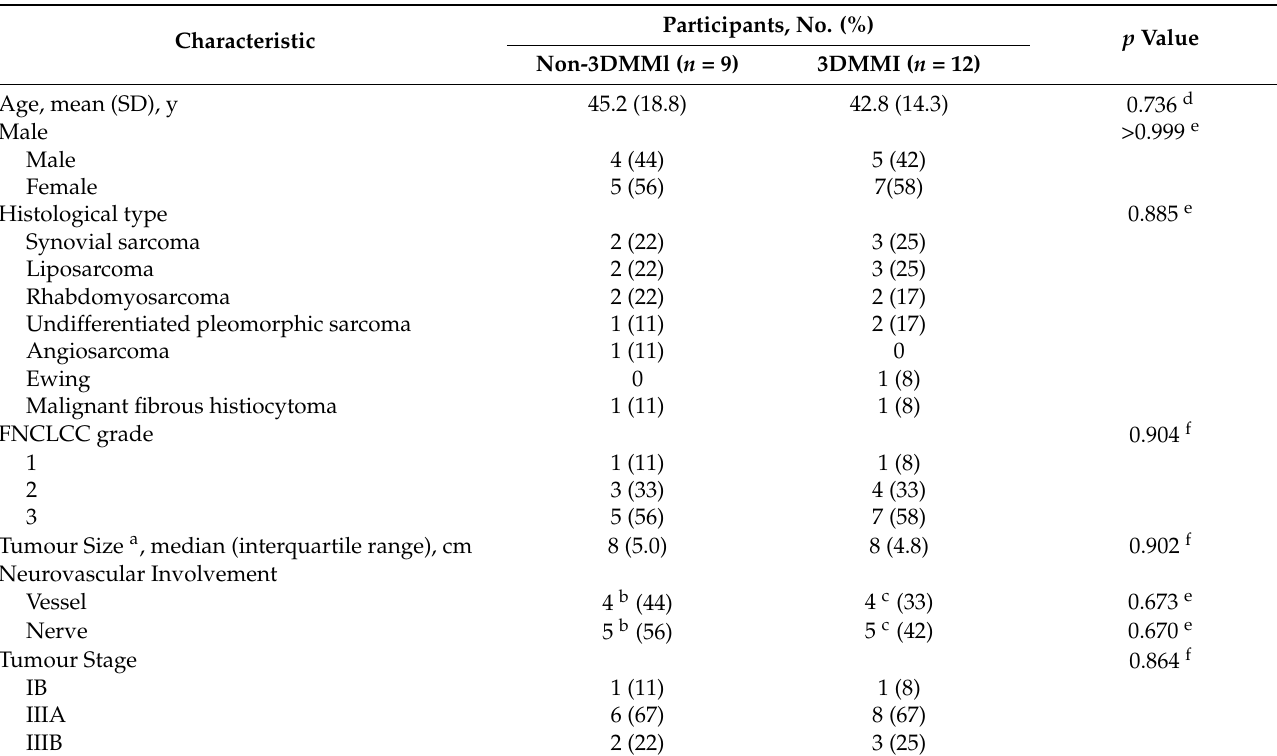
Table 1. Baseline characteristics between groups who underwent limb salvage surgery with and without 3DMMI-based preoperative